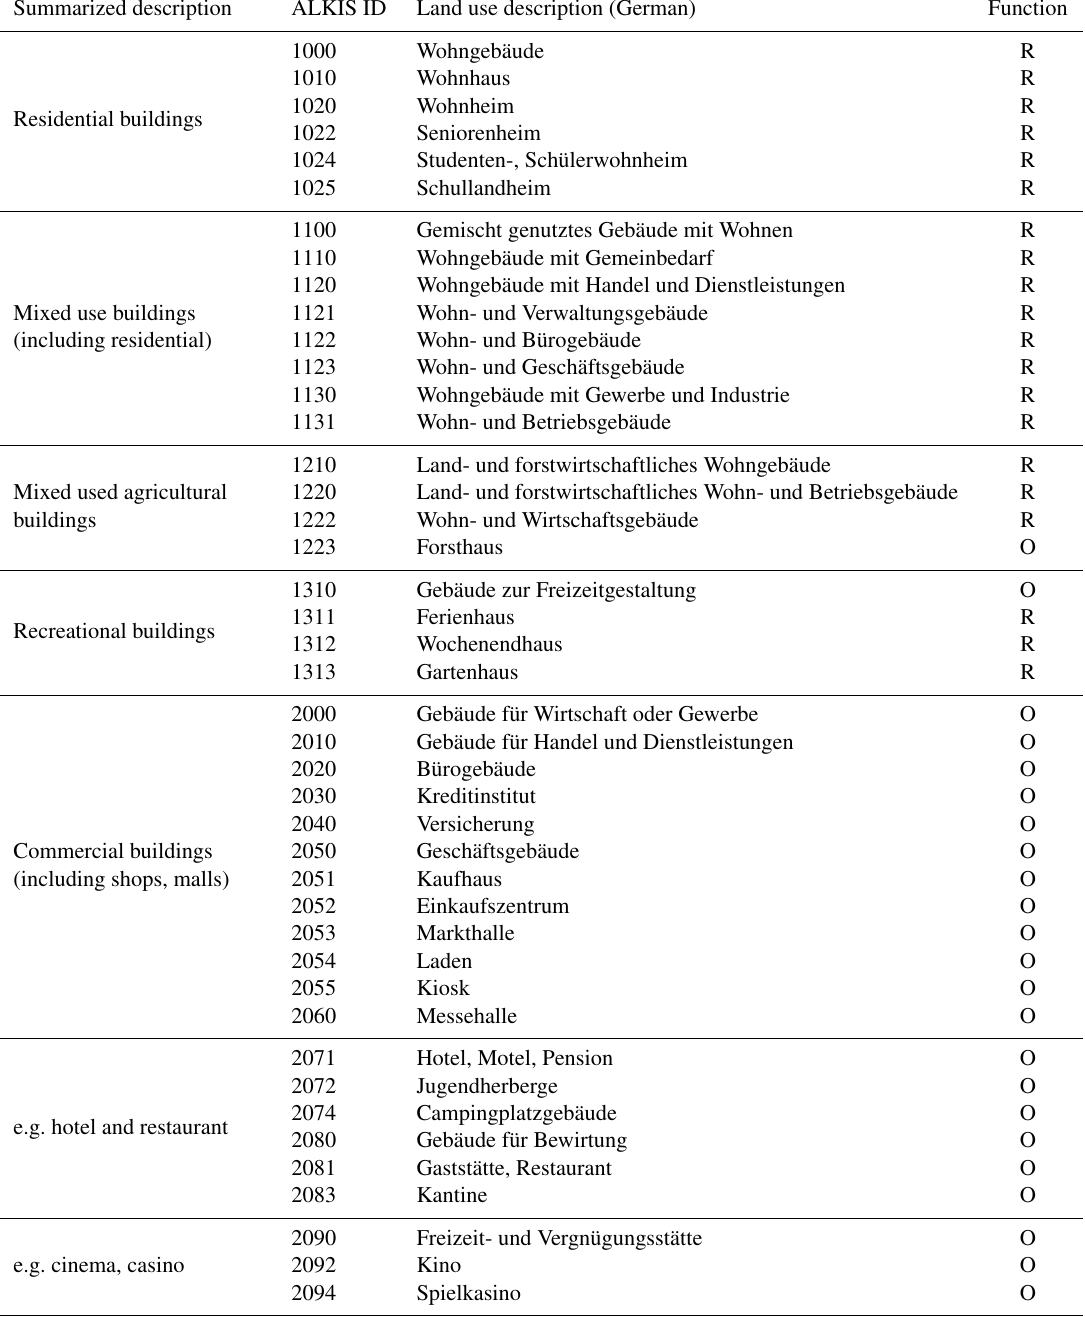
Table B8. ALKIS land use descriptions to PALM building type. The building function can be R = residential, O = other, X = no building. The combination of the function and the building age according to Table A2 results in the PALM building